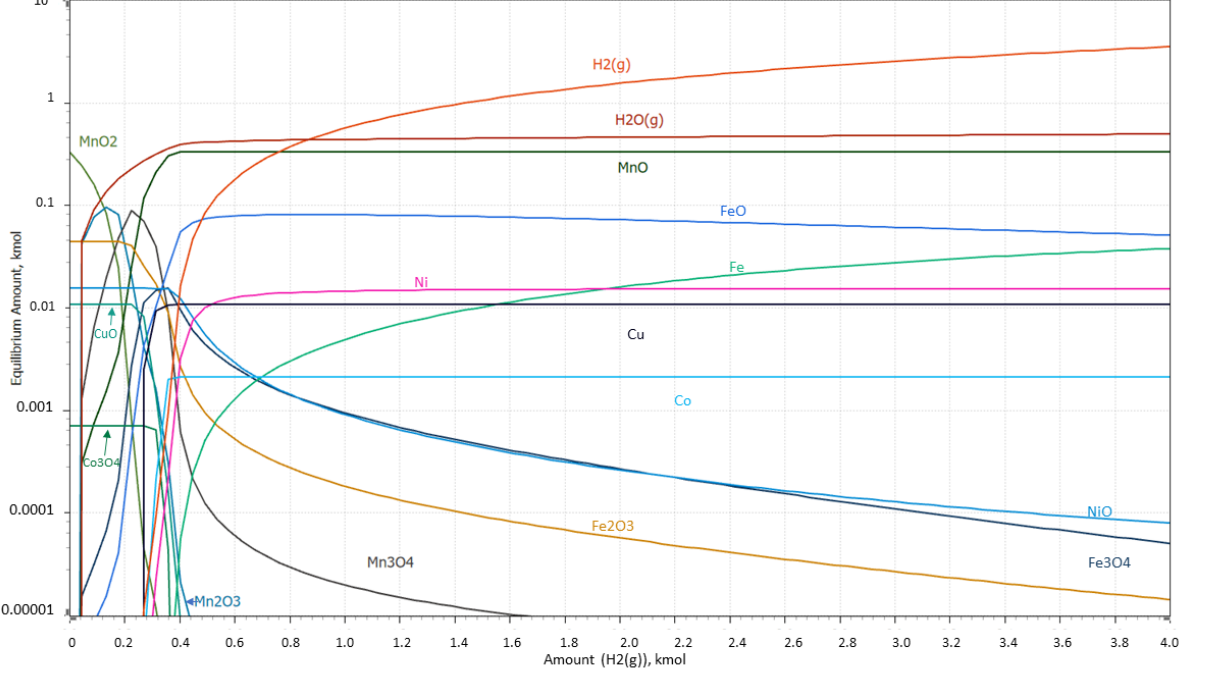
Figure 13. Equilibrium calculations when 100 kg calcined ore reacts with H 2 at 1173 K. Created using the equilibrium calculations module in HSC Chemistry 9.